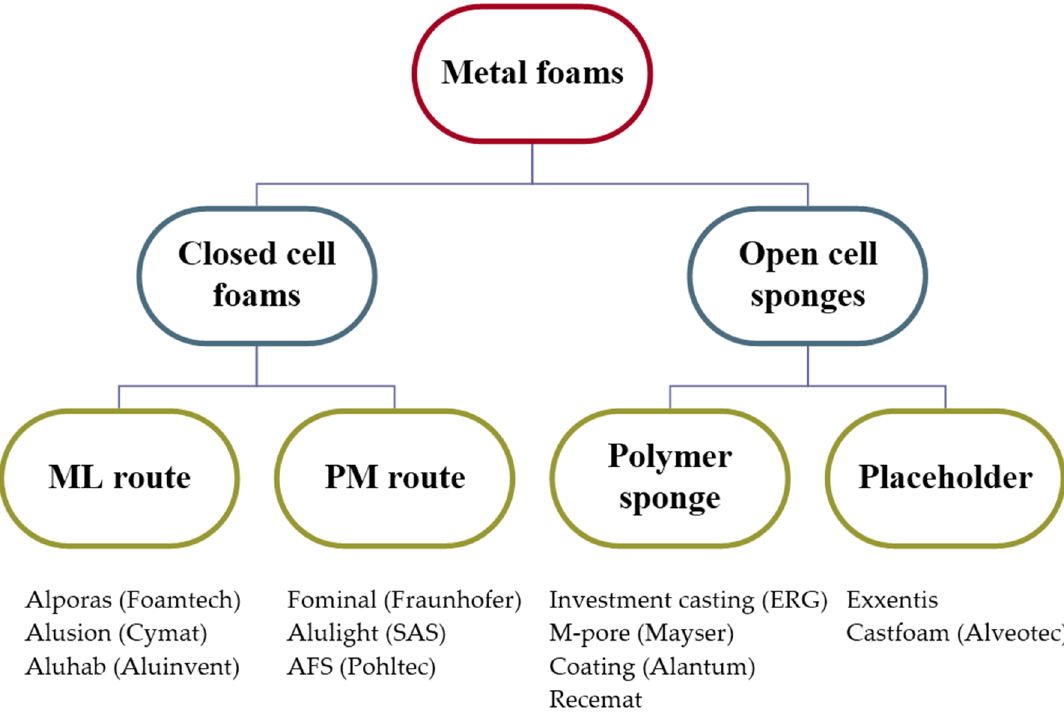
Figure 1. Schematic grouping of the commercially most relevant production methods of metal foams and sponges and some representative tradenames and companies. SAS, Slovak Academy of Sciences; AFS, aluminum foam sandwich; ML, melt; PM, powder metallurgical.